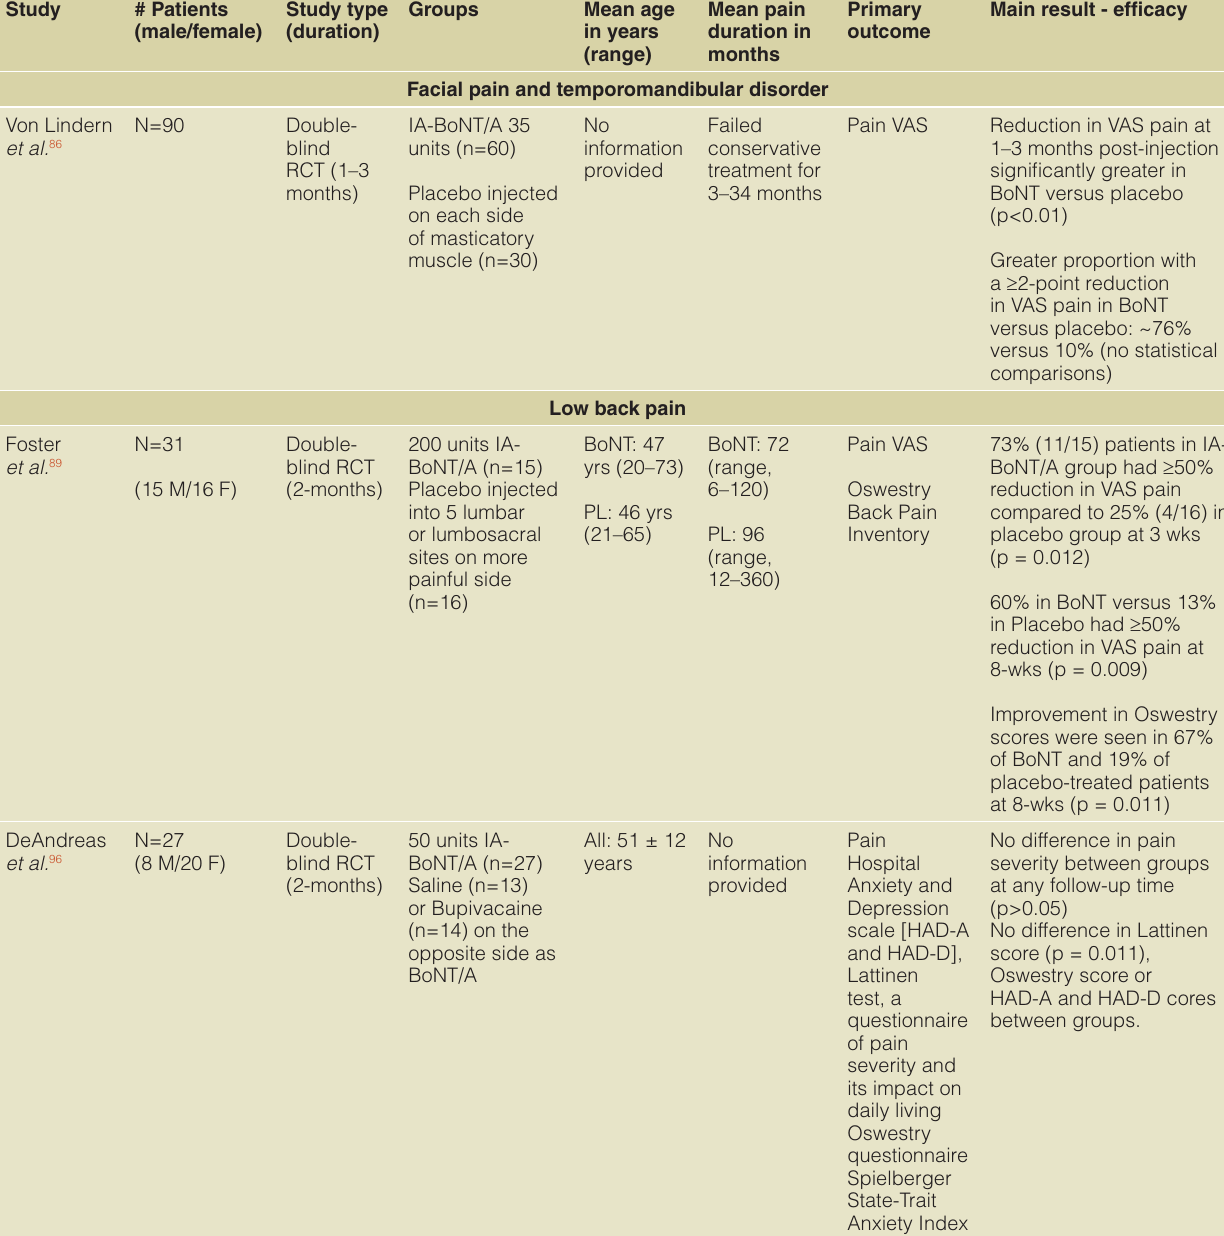
Table 3. Efficacy outcomes for botulinum toxin in temporomandibular disorder, low back pain, plantar fasciitis and carpal tunnel syndrome in randomized controlled trials. Study # Patients Study type (male/female)